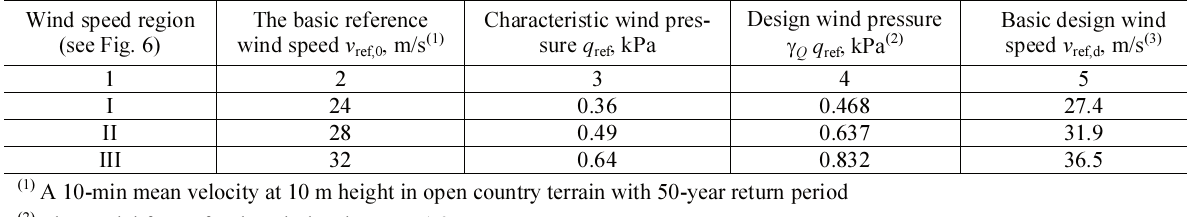
Table 2. Wind speed regions in Lithuania specified in the structural design code STR 2.05.04:2003 used since 2003 Wind speed region